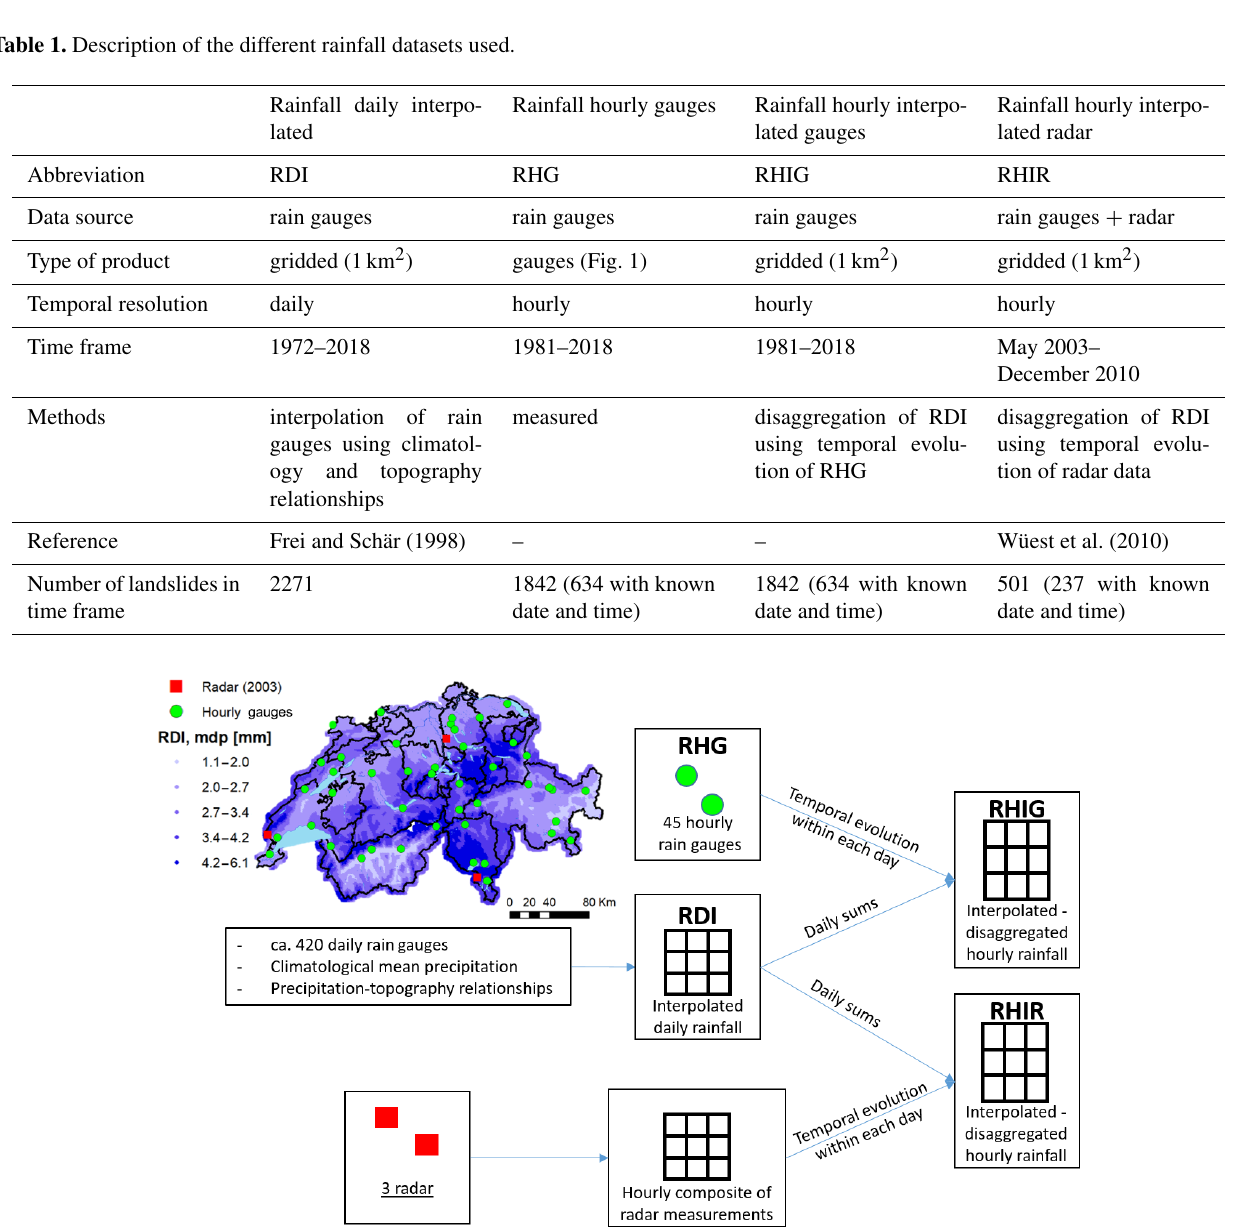
Figure 1. Map and scheme of the different rainfall datasets used in the analysis. The daily interpolated product (RDI), the hourly rain gauges (RHG), and the two derived hourly gridded products, which preserve the daily sums from RDI, but use the sub-daily temporal variability of a radar composite (RHIR) or of the hourly rain gauges